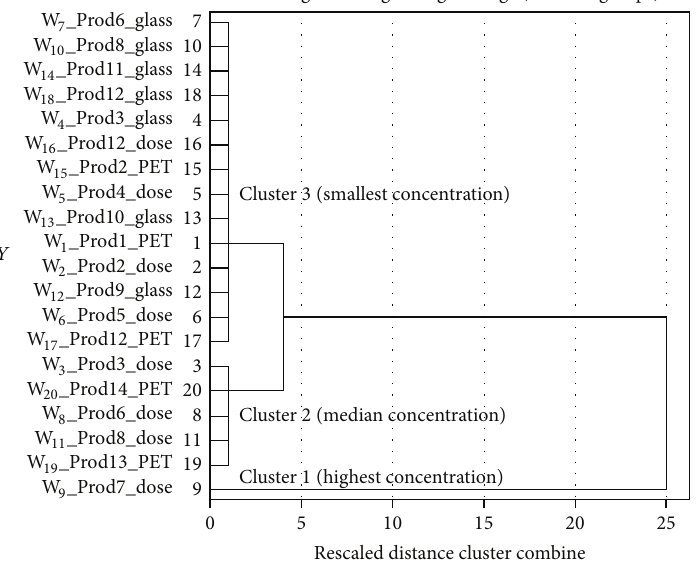
Figure 1: Dendrogram grouping the beer samples according to their mineral